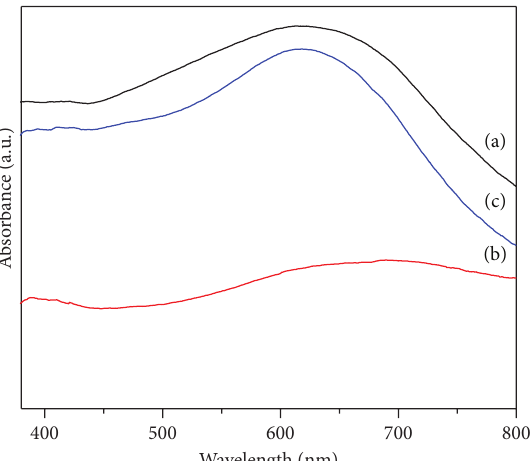
Figure 5: UV-Vis absorption spectrum of CuS nanostructures synthesized at 150 ∘ C for different reaction time (a) without CTAB 5 hrs (b) with CTAB 5 hrs (c) with CTAB 24